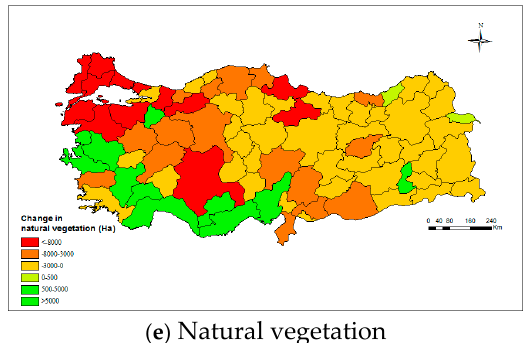
Figure A2. Change in specified land use types (Ha), Turkey, 1990–2012.